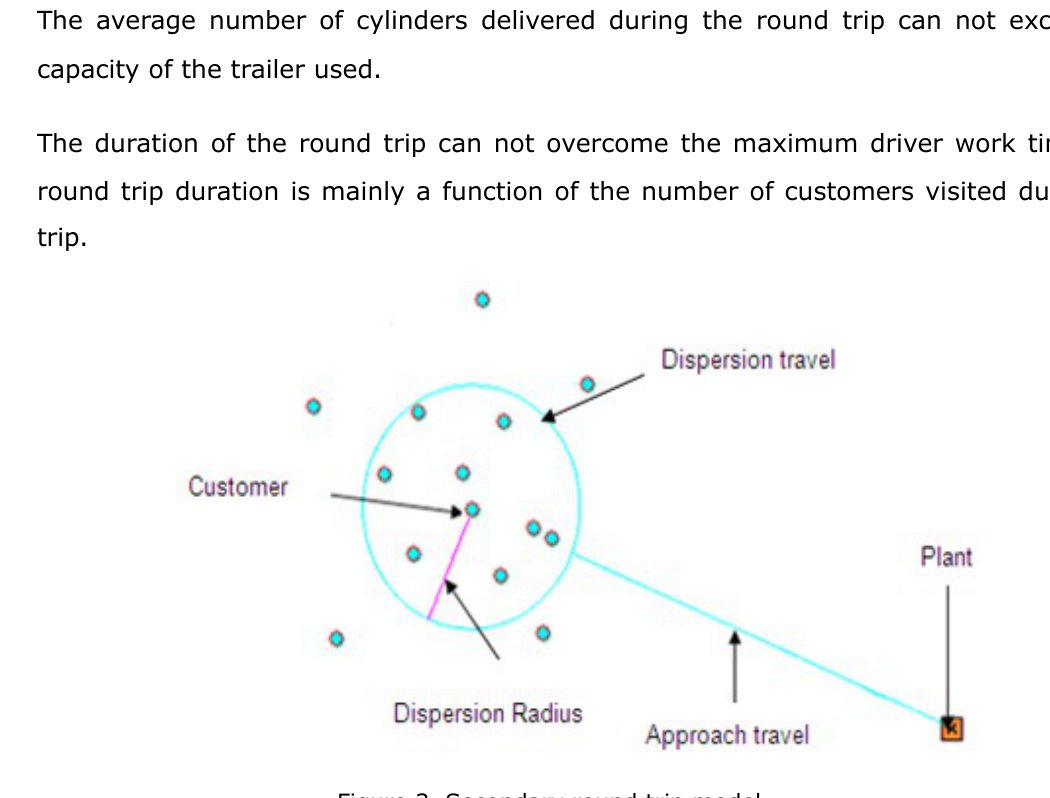
Figure 3. Secondary round trip